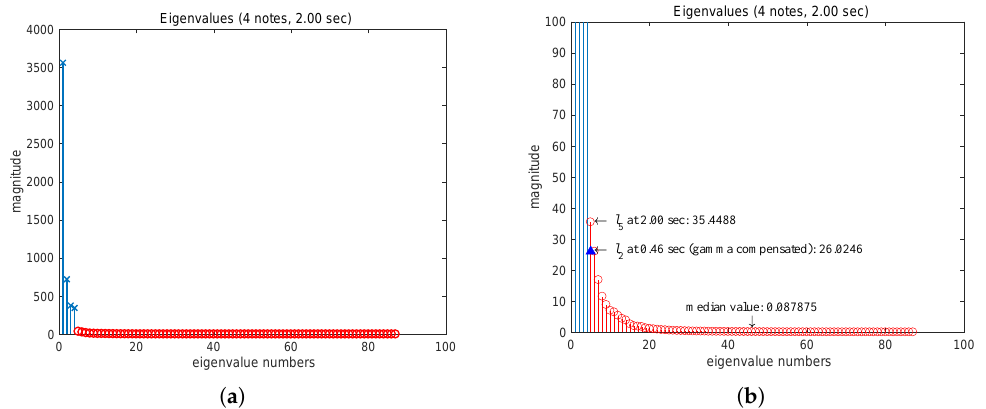
Figure 7. Eigenvalues of R v for all of the data ( N p = 87): ( a ) Full-scale display, ( b ) scaled display for noise eigenvalues, where “x” denotes a signal eigenvalue and “o” denotes a noise